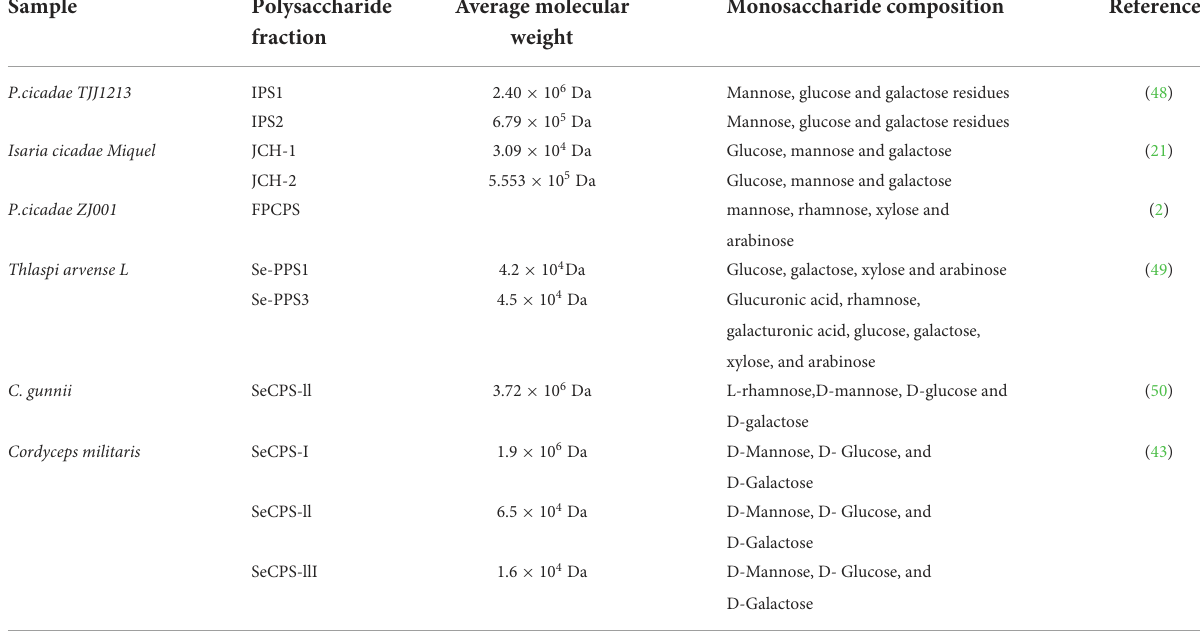
TABLE 2 Monosaccharide composition of polysaccharides extracted from different samples.